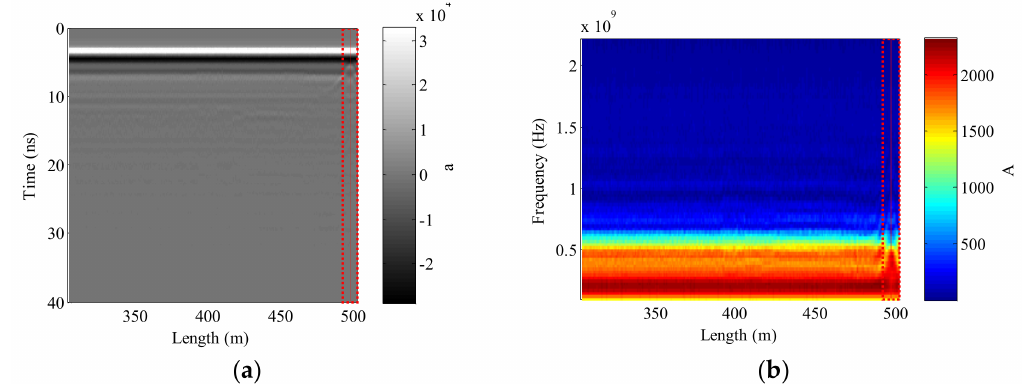
Figure 5. Example of spectrograms regarding the long sliding window of 200 m and the identification of the short sliding window of 10 m (delimited by dotted red lines): ( a ) in the time domain and ( b ) in the frequency